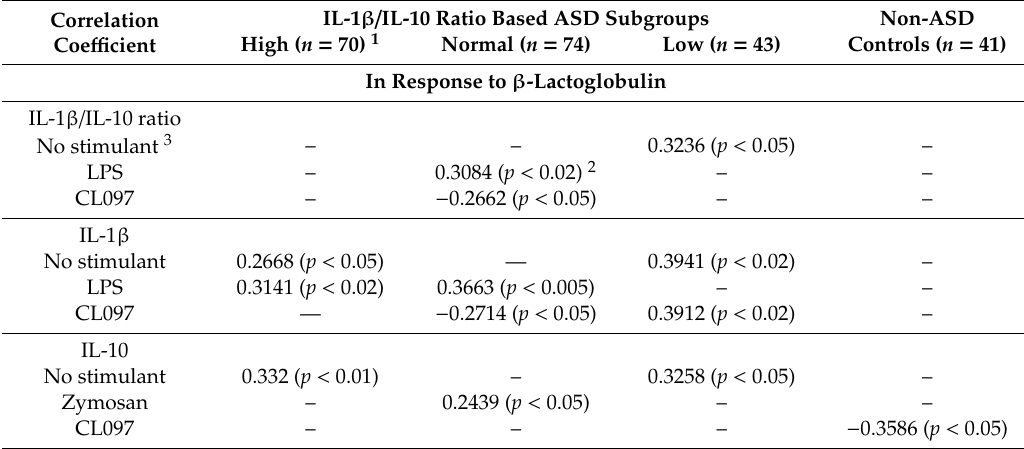
Table 5. Correlations between IFN- γ production by PBMCs and monocyte cytokine